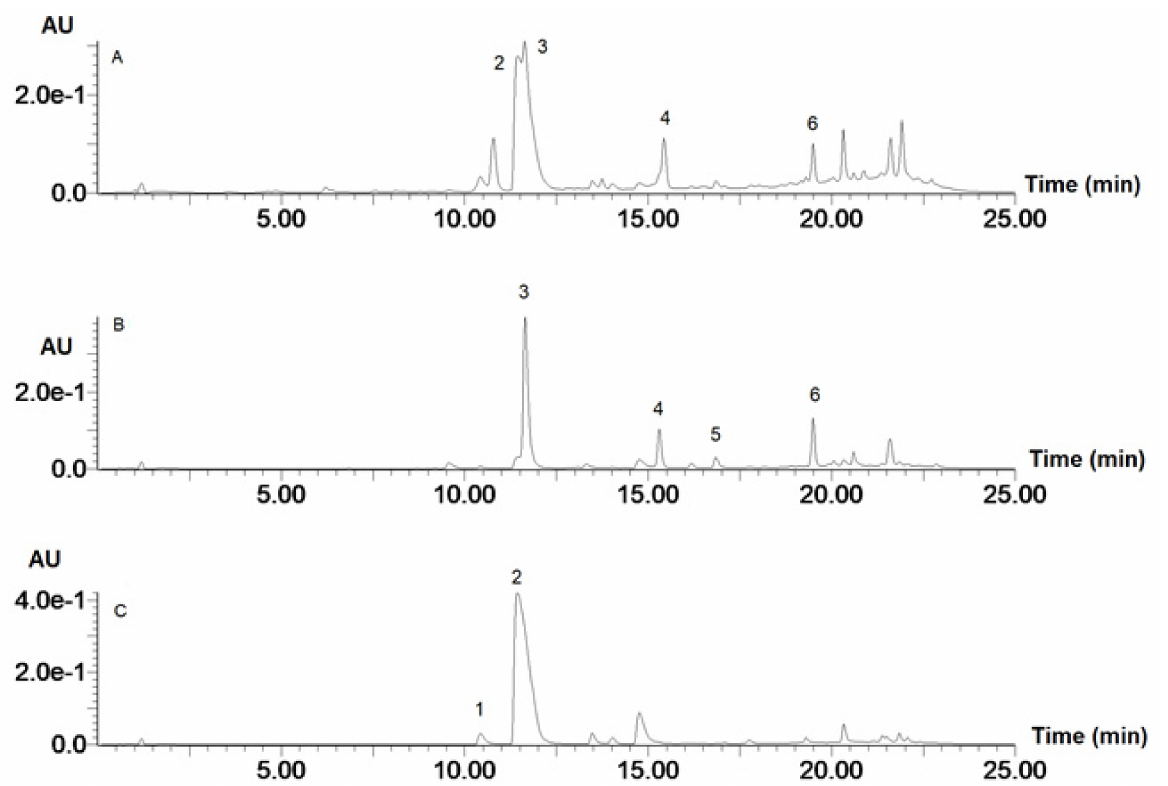
Figure 5. Liquid chromatogram for sorghum leaves at 280 nm ( A ), 350 nm ( B ), and 450 nm ( C ). Key: 1 = luteolinidin (RT = 10.42 min, m/z 269 amu); 2 = apigeninidin (RT = 11.43 min, m/z 253 amu); 3 = naringenin (RT = 11.63 min, m/z 271 amu); 4 = eriodictyol (RT = 15.43 min, m/z 287 amu); 5 = luteolin (RT = 16.85 min, m/z 285 amu); 6 = apigenin (RT = 19.48 min, m/z 269 amu). Apigeninidin was coeluted with naringenin, and so naringenin was identified and quantified at 350 nm, while apigeninidin was identified and quantified at 450